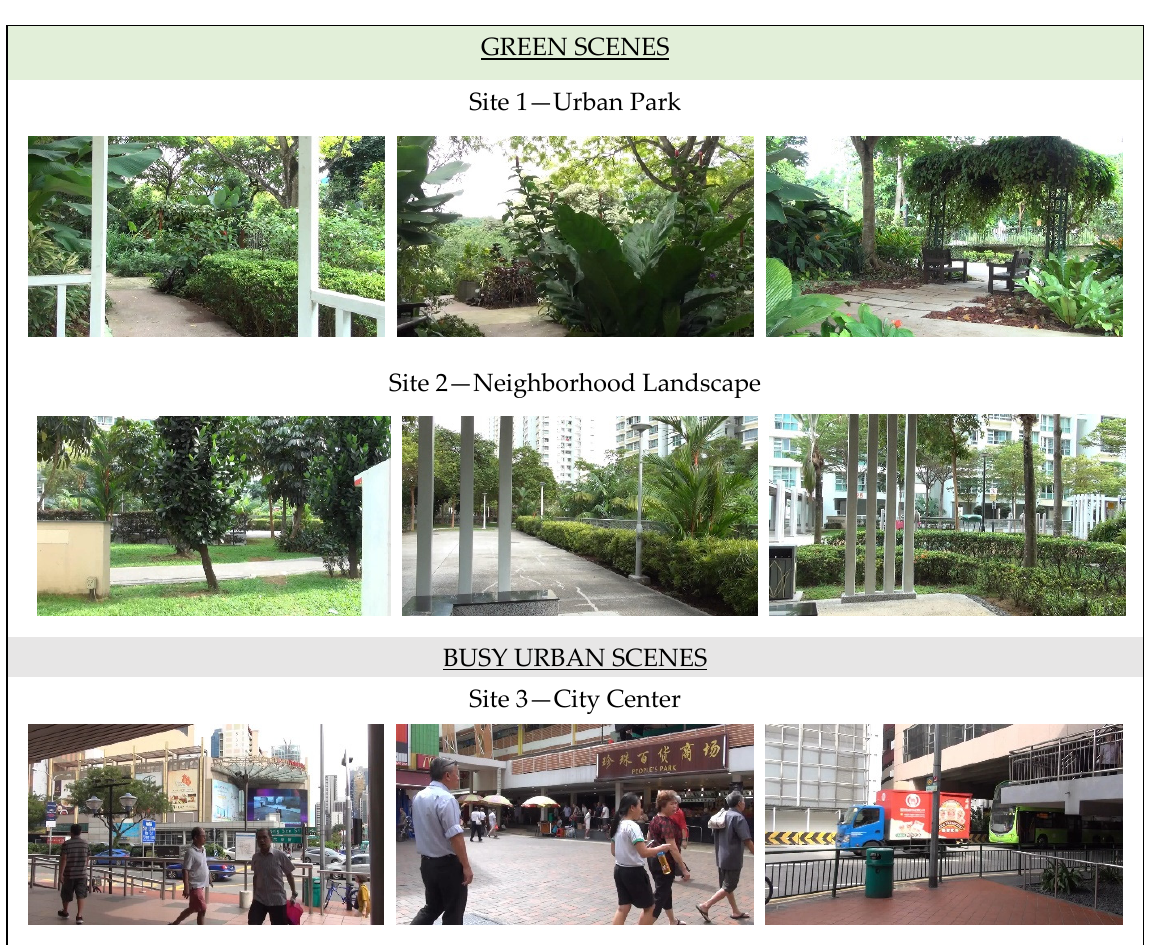
Figure 2. Photo snippets of the still-frame videos presented to participants.